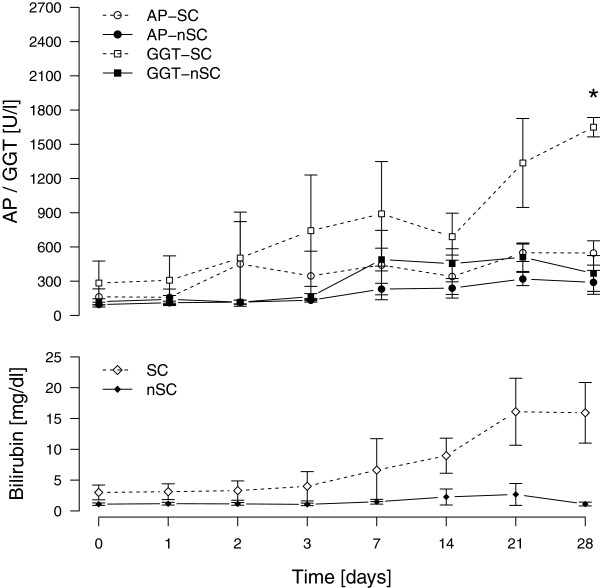
Temporal course of alkaline phosphatase (AP), γ-glutamyl transpeptidase (GGT) and total serum bilirubin levels in patients without (nSSC) and with (SSC) secondary cholangitis. * indicates significant difference (P = 0.001).